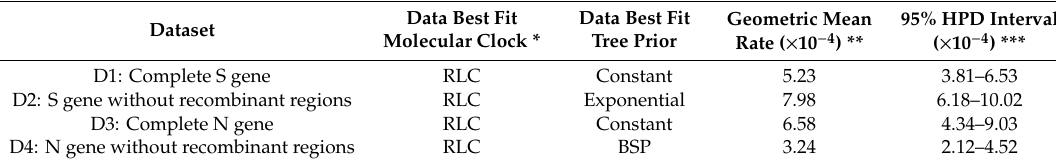
Table 3. Estimated nucleotide substitution rates for the S and N genes.